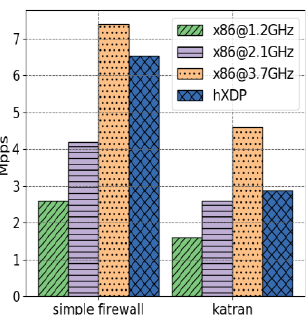
Figure 9. Comparable performance to an x86@2.1GHz for programs.